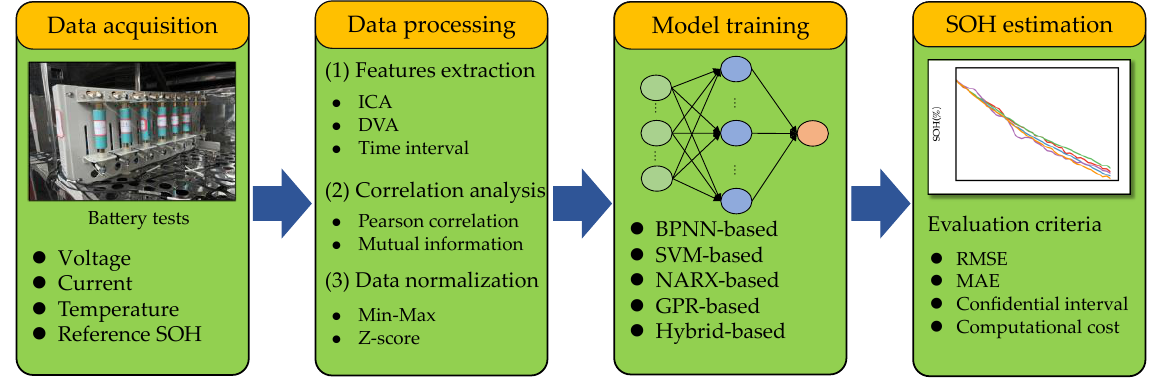
Figure 2. Procedures for developing data-driven SOH estimation algorithms.